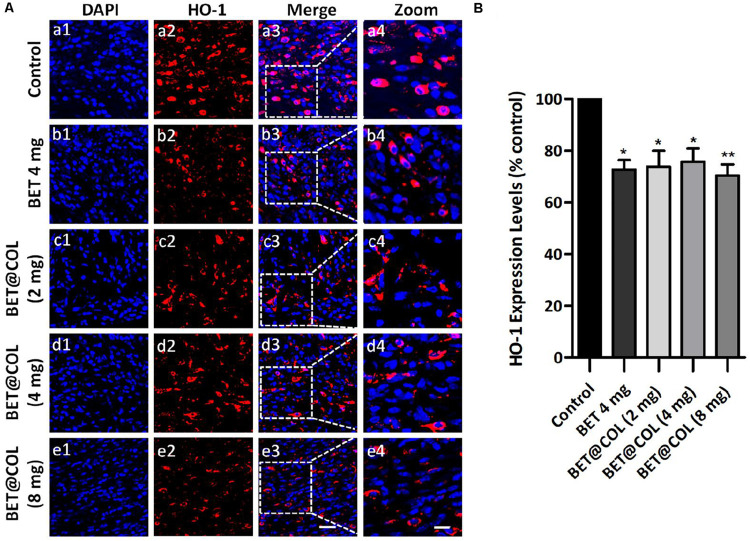
Betaine ameliorates oxidative stress level at wound sites. (A) Immunofluorescence photomicrographs of heme oxygenase-1 (HO-1) in wounds for the control group, the free betaine solution (4 mg) group and BET@COL (2 mg, 4 mg, and 8 mg) treated group on day seven. Scale bars: 20 μm [10 μm in magnified images (a4–e4)]. (B) Quantitative result of immunofluorescence, n = 5. BET, betaine; COL, collagen. Statistical differences were performed using ANOVA. **p < 0.01, *p < 0.05, compared to control group.